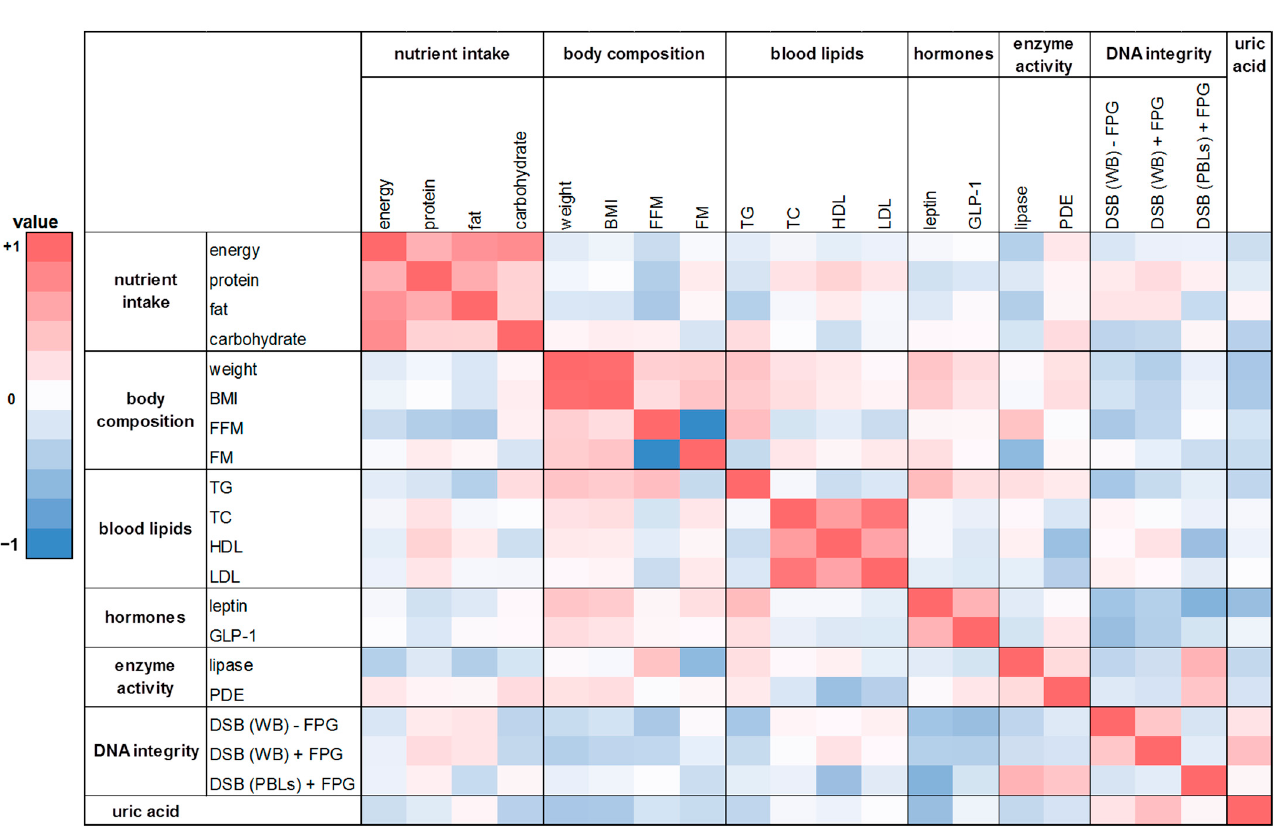
Figure 6. The heat map correlation matrix of all parameters investigated during the human inter- vention study. The coefficients were calculated based on the changes between the washout period and the intervention period after four weeks. Colored fields: red: positive correlation; blue: negative correlation. BMI: body mass index; DSB: DNA strand breaks; TC: total cholesterol; TG: triglyceride; WB: whole blood.